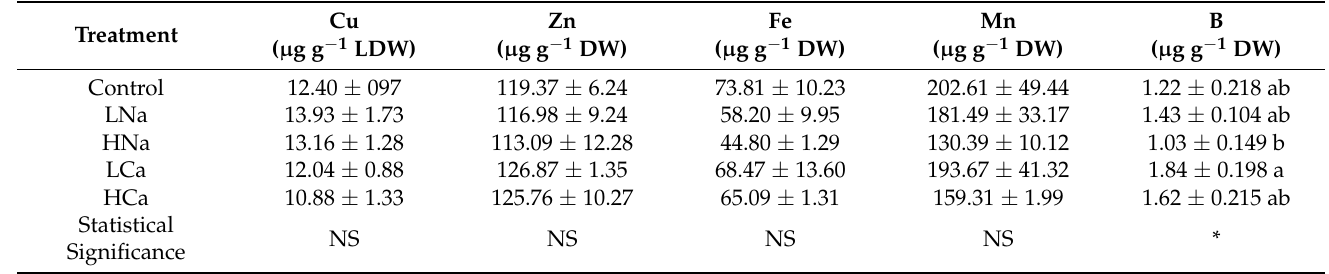
Table 3. Cu, Zn, Fe, Mn, and B ( µ g g − 1 of dry weight (LDW) in the leaves of Valerianella locusta plants grown in a floating system, as influenced by four salinity treatments (referred to as low and high salinity level) and the salinity source. Control: standard nutrient solution ( − 0.08 MPa, 20 ◦ C); LNa: low NaCl-salinity ( − 0.18 MPa, 20 ◦ C); HNa: high NaCl-salinity ( − 0.28 MPa, 20 ◦ C); LCa: low CaCl 2 -salinity ( − 0.018 MPa, 20 ◦ C); HCa: high CaCl 2 -salinity ( − 0.28 MPa, 20 ◦